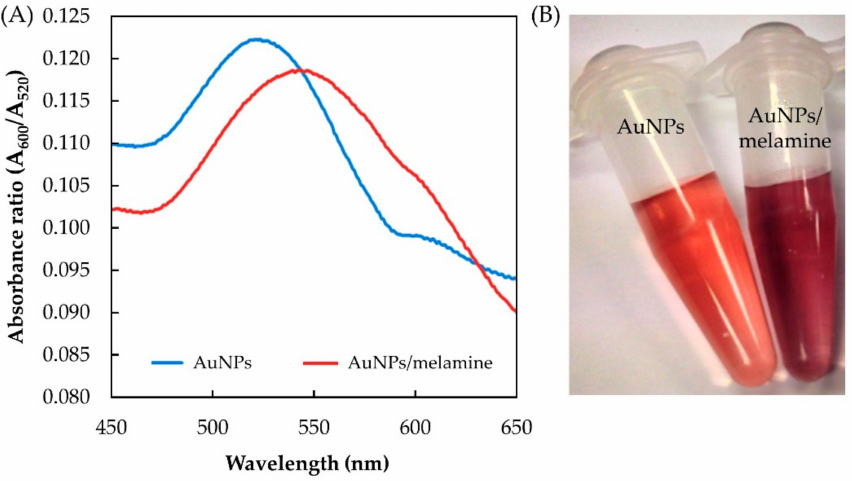
Figure 2. Absorbance spectra ( A ) and the color changes of AuNPs and AuNPs/melamine ( B